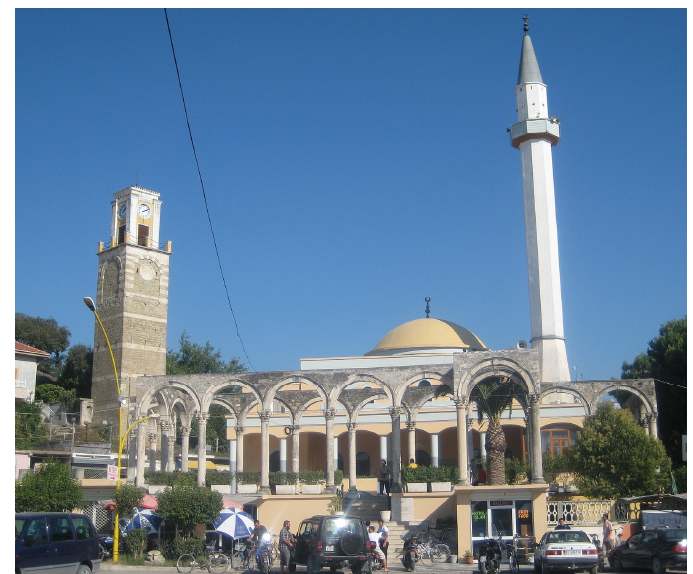
Figure 8. View of the Kubalie Mosque of Kavaja [11].